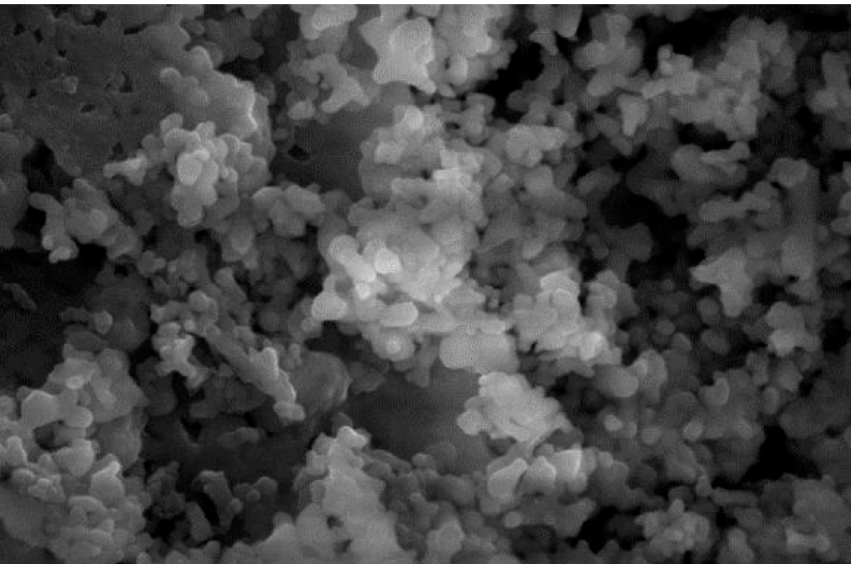
Figure 9. SEM result of the KI/HAP catalyst after three cycles of use.